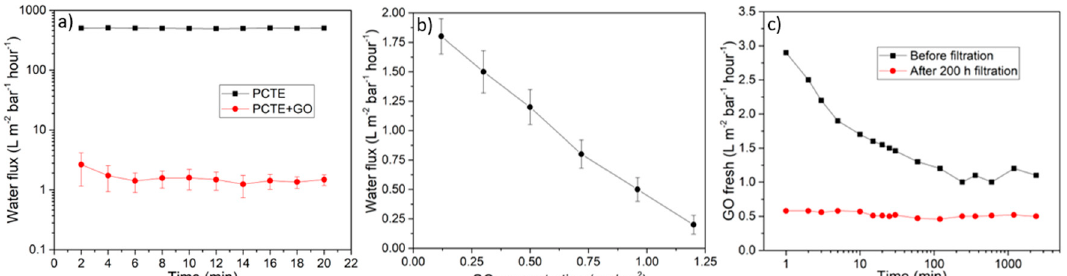
Figure 4. ( a ) Water flux comparison between the support layer alone (PCTE) and the support layer with the GO coating on top. Error bars are evaluated as the standard deviation of 10 different samples. Error bars on PCTE cannot be displayed in this scale. ( b ) The water flux through GO membranes with different thicknesses (reported as GO loading) at 1 bar of applied pressure is shown. ( c ) Water flux measured up to 2500 min on the same membrane, before filtration tests and after 200 h of operation.